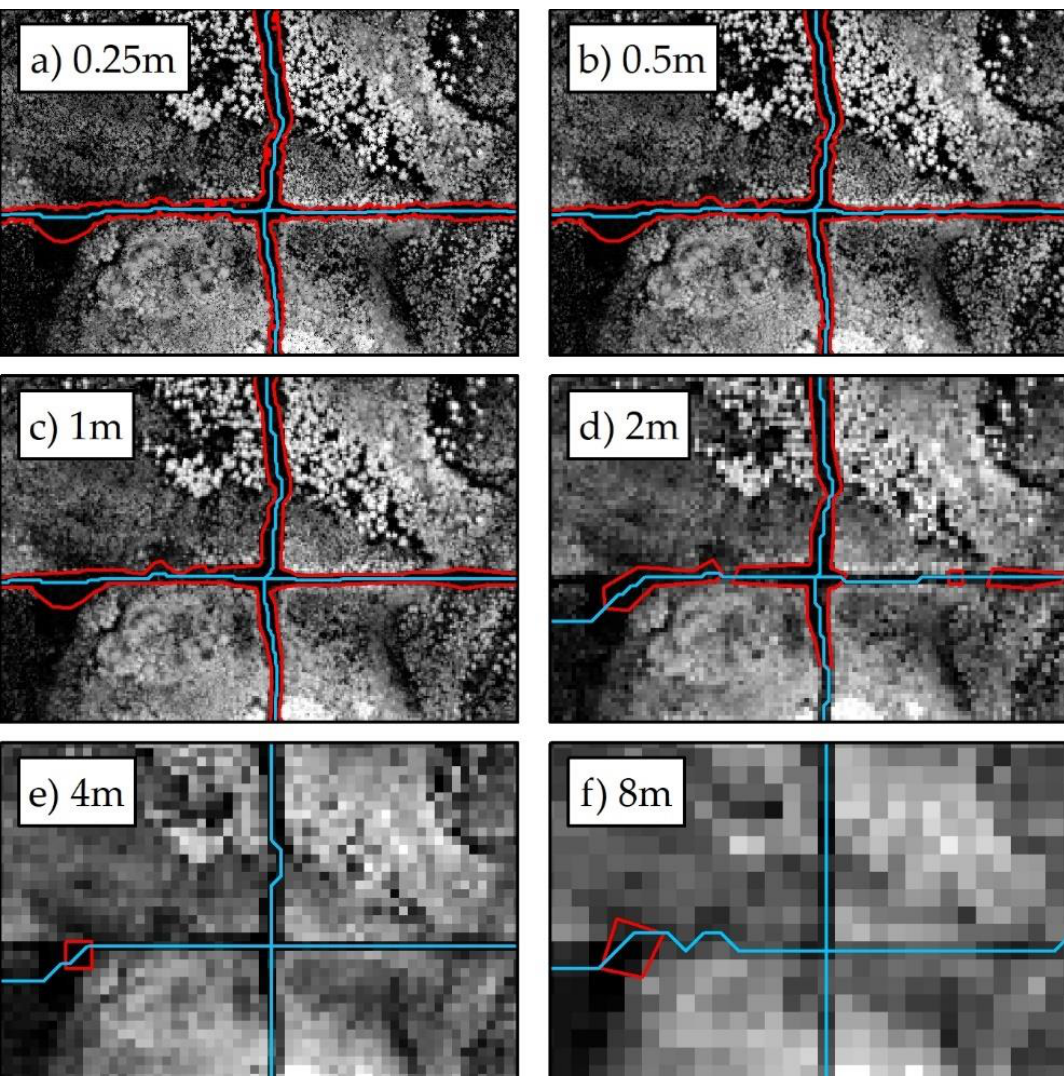
Figure 5. Output centerlines (blue) and footprint polygons (red) of legacy seismic lines mapped with the proposed software tool overlaid on CHM raster resampled from 25 cm ( a ) resolution to 50 cm ( b ), 1 m ( c ), 2 m ( d ), 4 m ( e ), and 8 m ( f ).